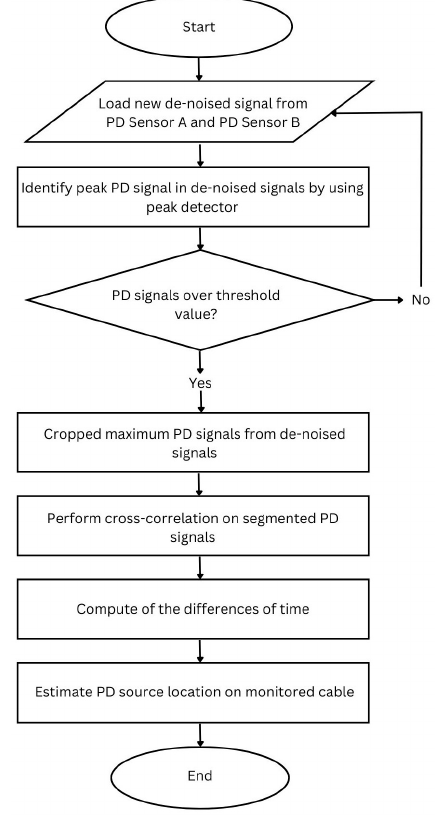
Figure 5. Process flow of the SC algorithm.